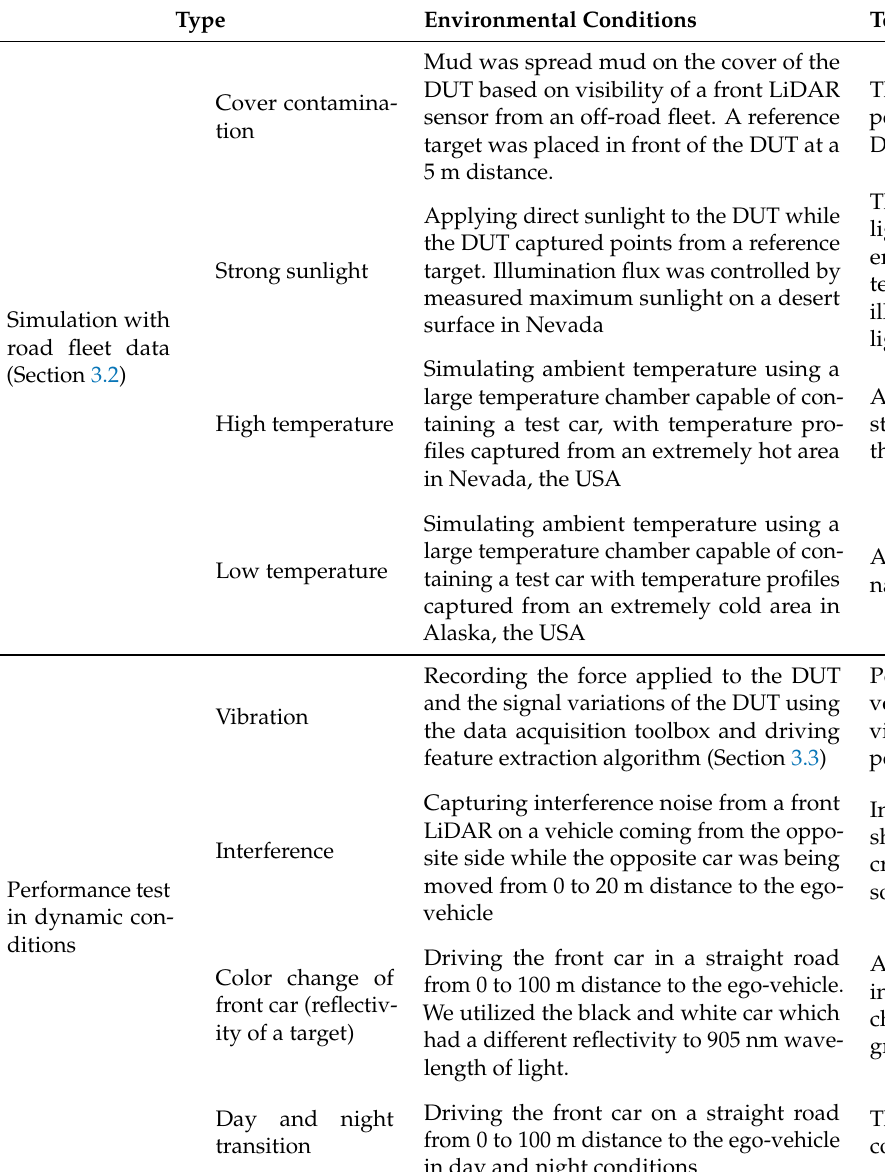
Table 1. Summary of environmental test scenarios and